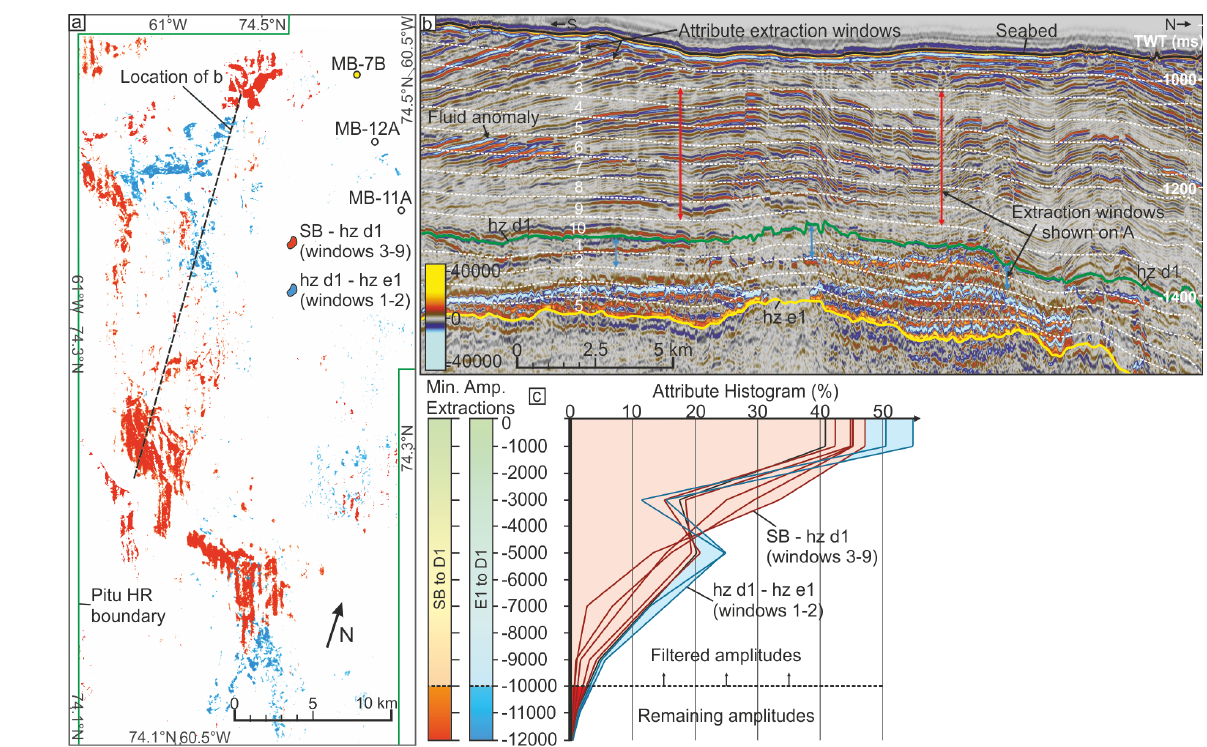
Figure 8. Shallow gas detection. (a) A 2D map view of several overlaid windowed minimum amplitude extractions from the Pitu HR survey that have been filtered to only display amplitudes that are greater than − 10000 and likely represent fluid anomalies. The extracted amplitudes have been colour coded to distinguish between windows from different mega-unit packages, giving a sense of anomaly depth, a technique which can also be applied to individual windows. The windows displayed are shown in both panels (a) and (b) . The IODP Proposal 909 sites in this area are also shown in locations that avoid the potential fluid anomalies as well as the location of the seismic line used in panel (b) . (b) A seismic cross section from the Pitu HR survey that highlights the main horizons used to create the proportionally distributed extraction windows. Several seismic anomalies that will be identified within the extractions are also shown along with the specific windows displayed in panel (a) . (c) A histogram that shows the distribution of amplitudes from the selected extraction windows shown in panels (a) and (b) . The histogram and the colour bars show how the amplitudes have been filtered to only show the extreme values which are more likely to represent fluid anomalies. These amplitude cut-offs can be altered for specific windows to either display or hide certain amplitude